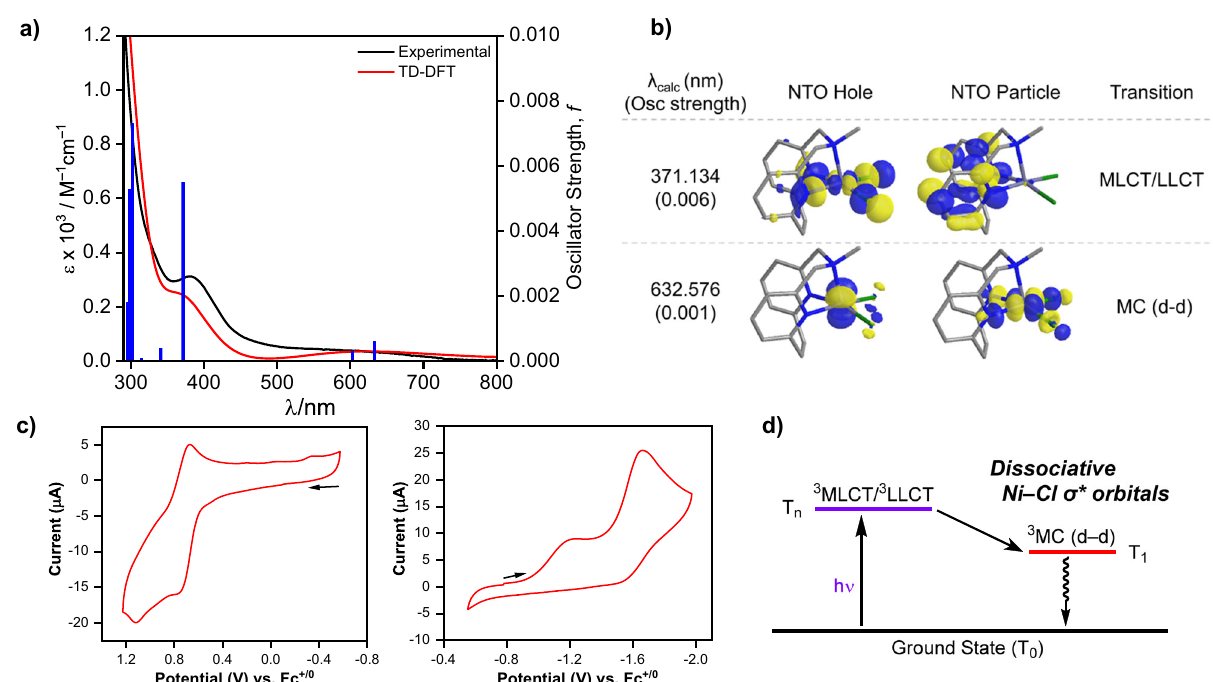
Fig. 3 Characterization of 1a. a Experimental (black line) and simulated (red line, using Gaussian peak shapes with a full width at half maximum FWHM of 0.33 eV) UV – vis spectrum of 1a with overlaid relevant oscillator strengths (solid blue bars) from TD – DFT calculations. b Natural transition orbitals (NTOs, 0.05 isocontour value) associated with the visible absorption bands of 1a. c Cyclic voltammograms (CVs) of 1a in 0.1 M TBAPF 6 /MeCN (scan rate 0.1 V/s). d A simpli fi ed excited-state diagram for 1a, showing the population of the lower energy excited state, a 3 MC d-d a pseudoreversible reduction wave at − 1.60 V vs Fc + /0 for 1a and − 1.72 V for 1b , respectively. The fi rst reduction wave is proposed to correspond to the conformation of the Ni complex in which the R N3 ligand adopts a κ 2 binding mode, in line with the fl